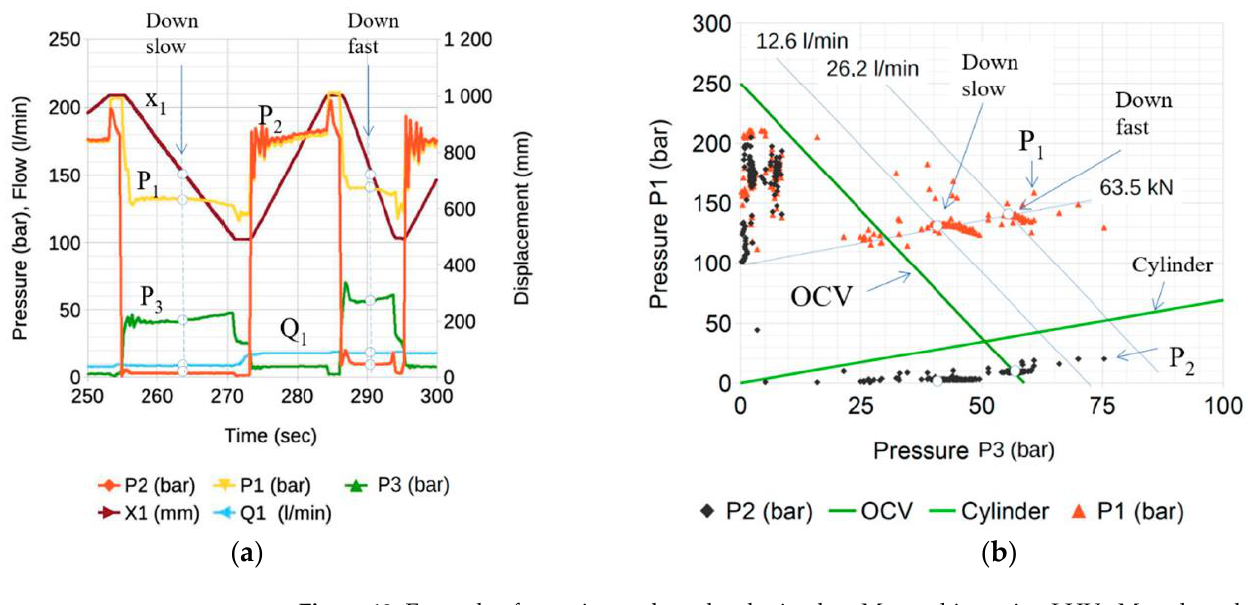
Figure 12. Example of experimental results obtained on M 1 machine using LHV 4 -M 1 valve where: ( a ) shows the temporal evolution of the experimentally measured variables. ( b ) experimental results plotted on steady-state operating curves for P 1 = f ( P 3 ).